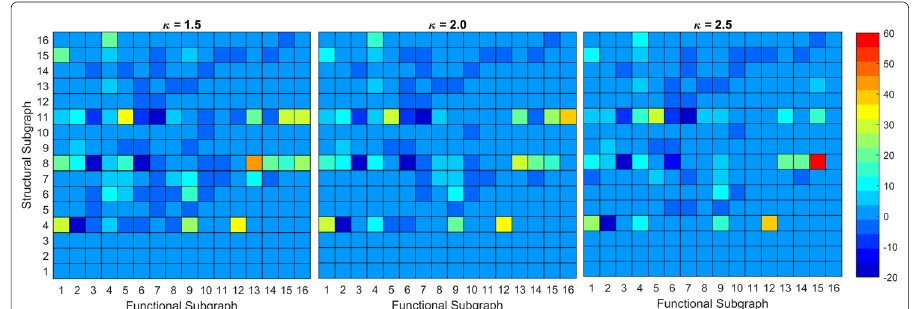
Fig. 12 Triadic Z -scores for CC reconstruction of the 1024 neuron network. Heatmap of the Z -scores of the larger network using the Gaussian correlation method for functional